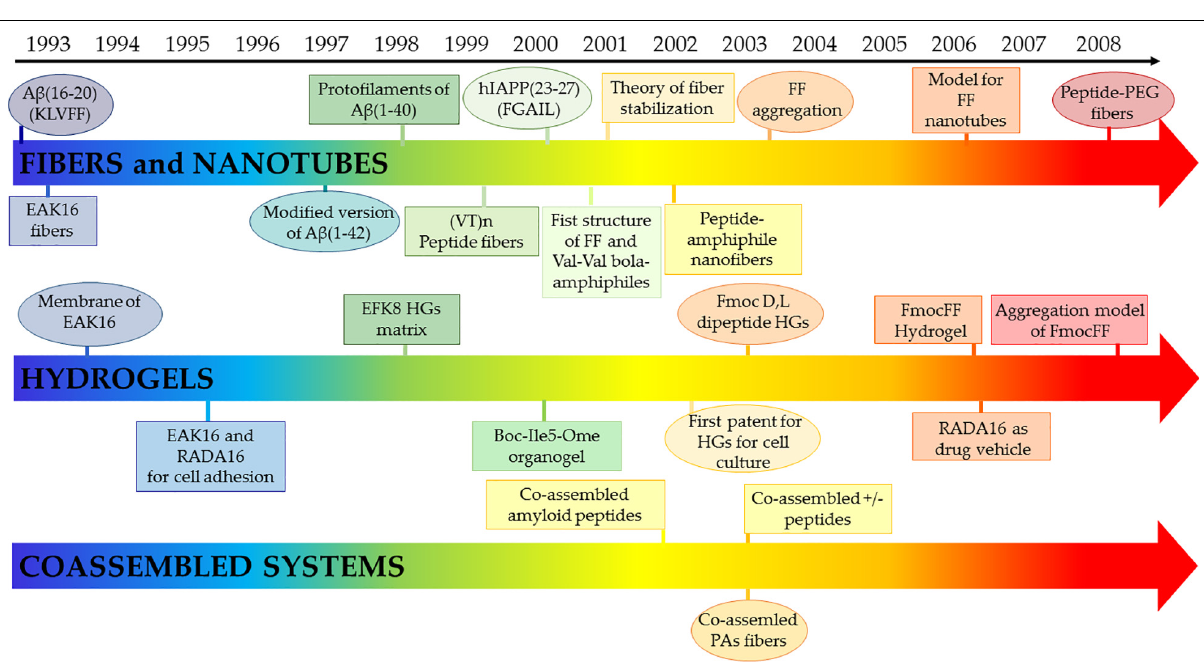
FIGURE 7 | Selected early milestones on self-assembling peptides assuming cross- β structures as elements for fibers and nanotubes, hydrogels and co-assembled biomaterials. Reference for each group are reported following. Fibers and nanotubes: A β (16-20) (KLVFF) (Hilbich et al., 1992); EAK16 fibers (Zhang et al., 1993a); modified version of A β (1-42) (Seilheimer et al., 1997); protofilaments of A β (1-40) (Malinchik et al., 1998); (VT)n peptide fibers (Janek et al., 1999); hIAPP(23-27) (FGAIL) (Tenidis et al., 2000); Val-Val bola-amphiphiles (Kogiso et al., 2000); theory of fiber stabilization (Nyrkova et al., 2000); first crystallographic structure of FF (Görbitz, 2001); peptide-amphiphile nanofibers (Hartgerink et al., 2002); FF aggregation (Reches and Gazit, 2003); model for FF nanotubes (Görbitz, 2006); peptide-PEG fibers (Hamley and Krysmann, 2008). Hydrogels: membranes of EAK16 (Zhang et al., 1993b); EAK16 and RADA16 for cell adhesion (Zhang et